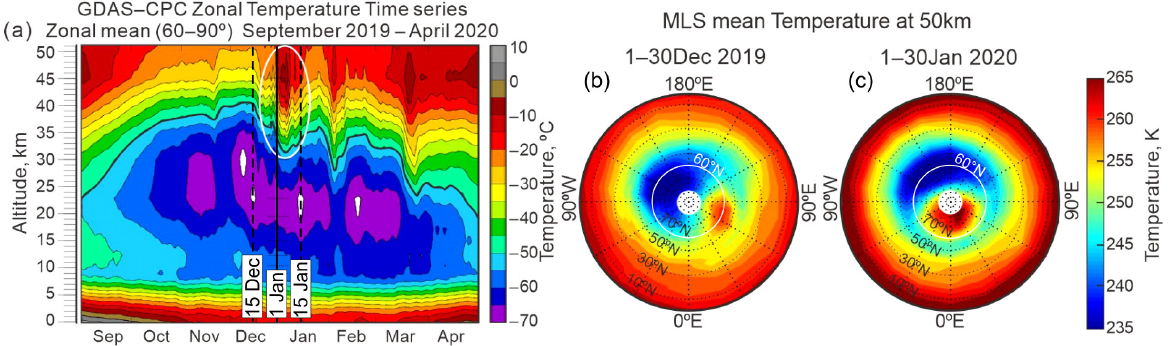
Figure 2. ( a ) GDAS–CPC temperature variations in a time–altitude section from the 60–90° N mean in September–April 2019/2020 [45]. The black curve shows the vertical change in the –50 °C temper- ature contour and the white oval outlines the warming peak in early January 2020. Monthly mean MLS temperature [43] in the NH at the mean stratopause height (50 km) in ( b ) December 2019 and